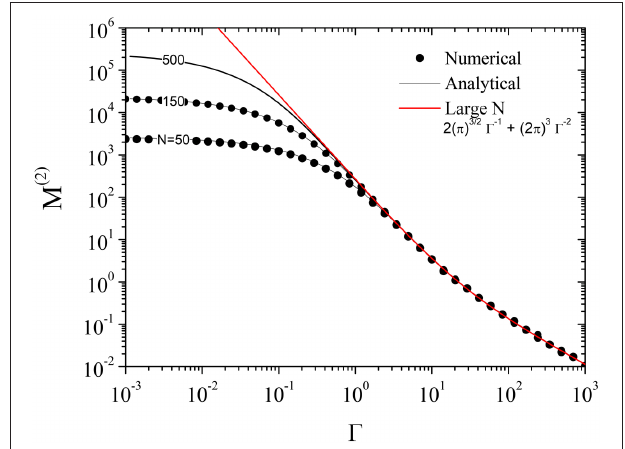
FIGURE 3 | Comparison between the analytical (full lines, from Equations 9 and 55) and numerical (black dots) results for the first moment M (1) of the ω 2 are the eigenvalues of the dynamical spectral density of states ρ ( λ ). λ = matrix and ω are the characteristic frequencies. The data at the indicated selected N values are reported as a function of the parameter Ŵ . The N values ( N = 50, 100, 150, 200, 300, 500, 1,000, and 10,000 for the analytical case and 50 and 150 for the numerical one) are indicated on the black curves. The red line is the asymptotic, N , limit reported in Equation (58). →∞